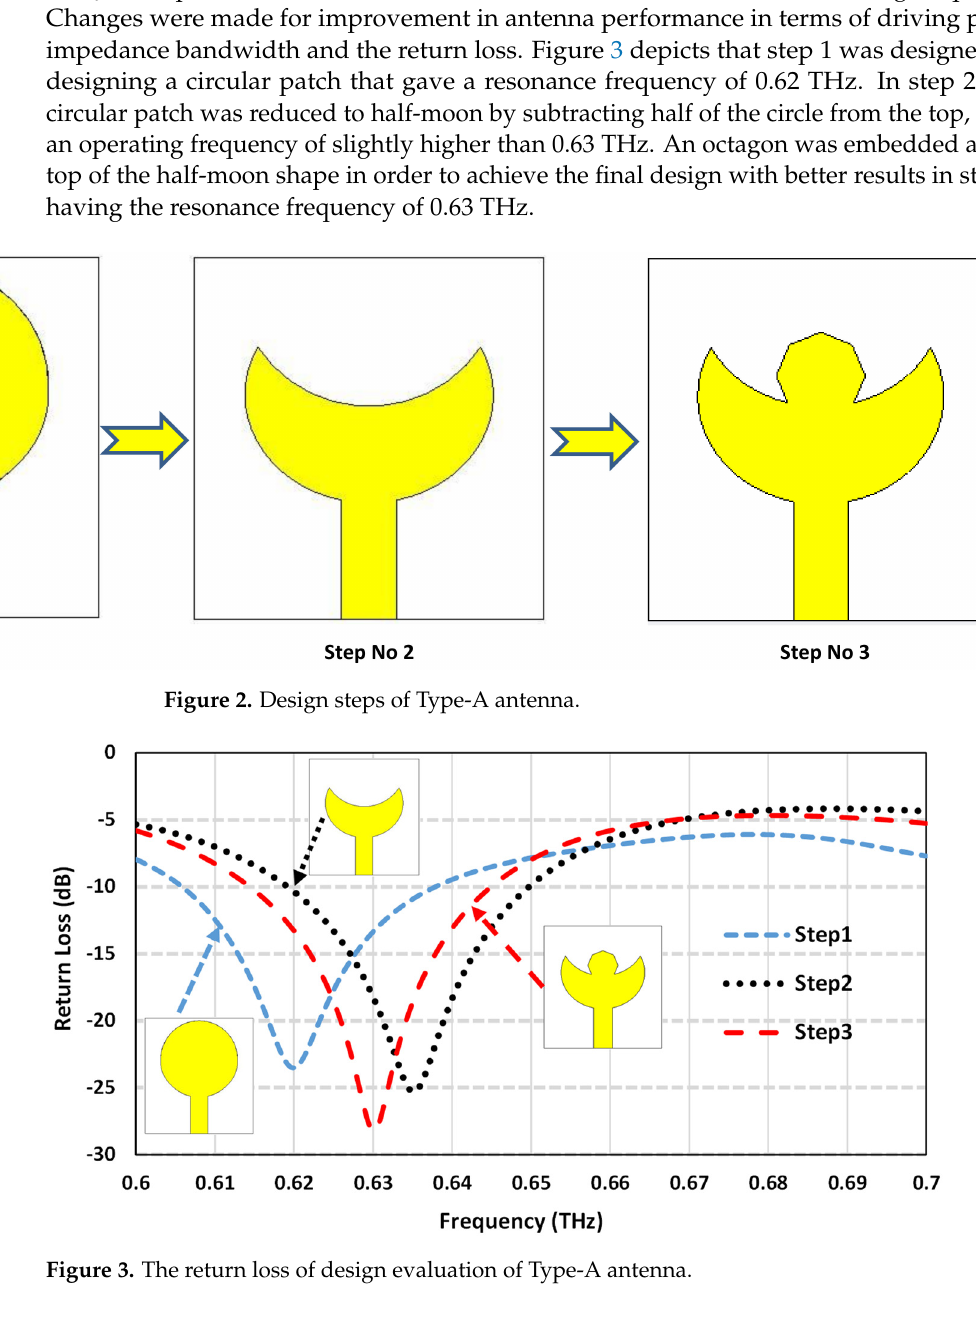
Figure 4. Comparison of return loss. As shown in Figure 5, the VSWR of the four antennas was found to be less than 1.5 within the operational bandwidth of the antennas, which shows that the antennas were optimally matched to the feed line. It can be observed in Figure 6 that the Type-D antenna gave a better peak gain of 9.45 dB at the resonant frequency for wider bandwidth, as com- pared to the rest of the three THz antennas. The comparison of the radiation efficiency plots in Figure 7 shows that the PBG-based THz antennas are more efficient (87–90%) as compared to the Type-A THz antenna, which was based on a homogeneous substrate with a radiation efficiency of 80%. The better efficiency of the PBG-based antennas is due to the suppression of the surface waves by the PBG structure.